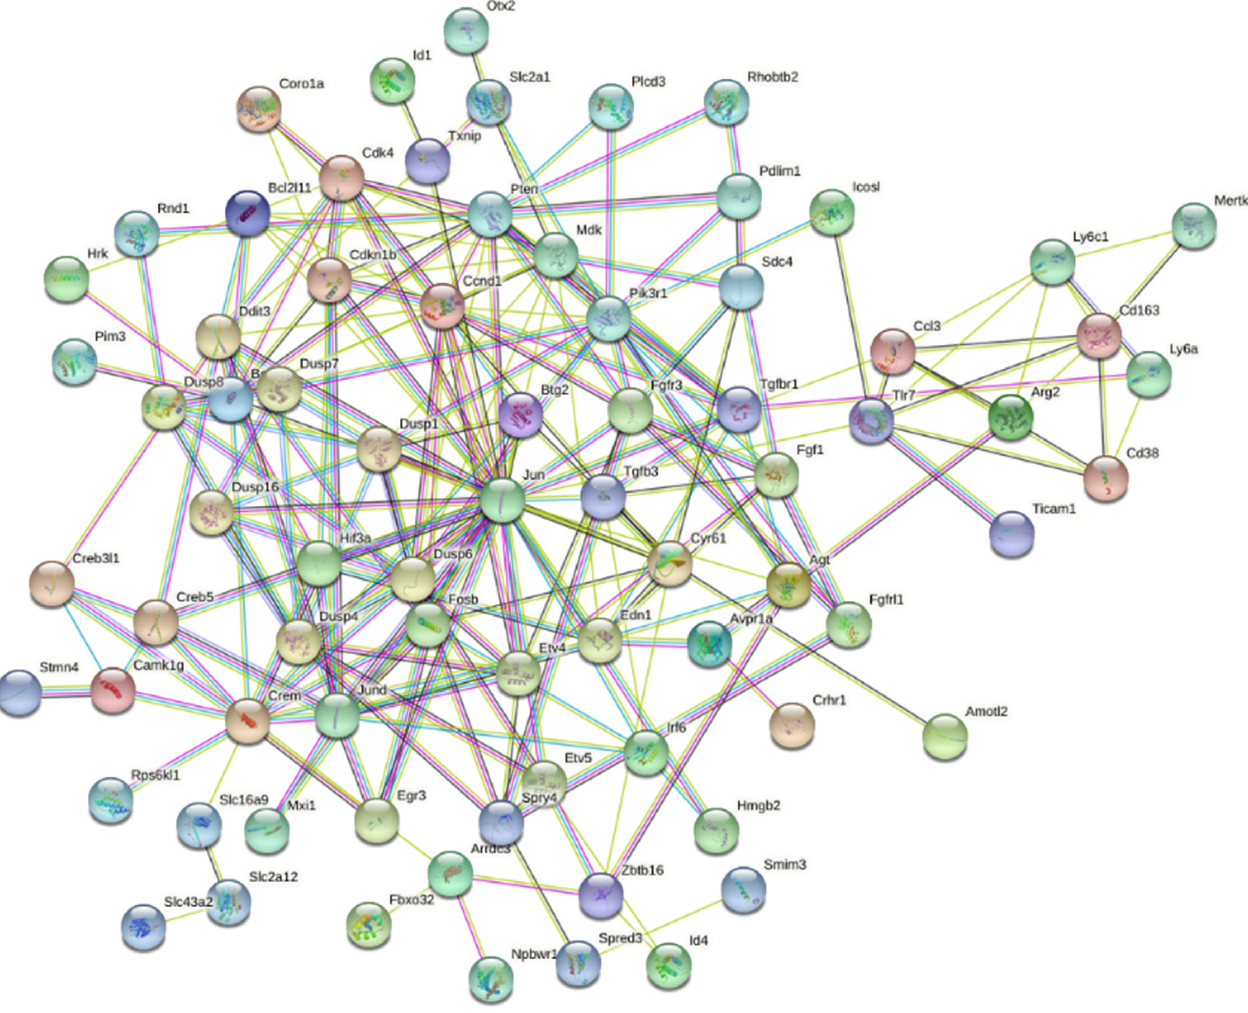
Figure 5. Network of inter-related genes that show differential gene expression changes after postnatal ethanol exposure. Many genes that showed a significant strain × treatment interaction ( adjp < 0.05) and fold change greater than 1.5 were highly inter-related. The edges between nodes represent predicted functional associations: green line- neighborhood evidence, blue line- co-occurrence evidence, purple line- experimental evidence, yellow line- textmining evidence, light blue line- database evidence, and black line- co-expression evidence. Node colors are randomly assigned and known protein structures are depicted. Network analysis was performed using tools available at STRING (www.string-db.org), with FDR adjp < 0.05.